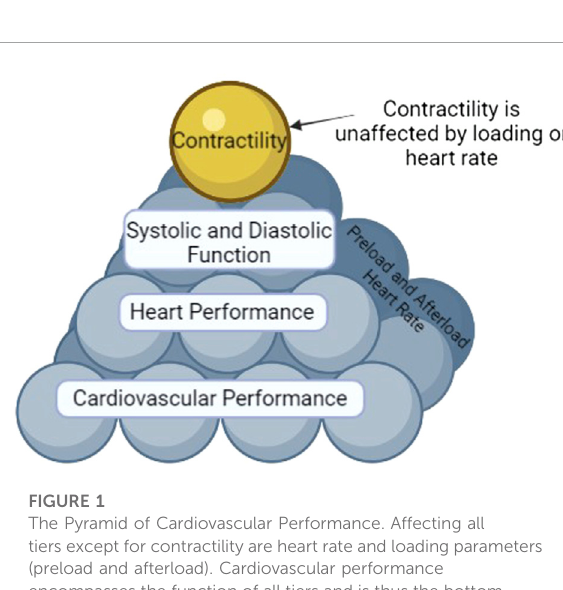
FIGURE 1 The Pyramid of Cardiovascular Performance. Affecting all tiers except for contractility are heart rate and loading parameters (preload and afterload). Cardiovascular performance encompasses the function of all tiers and is thus the bottom of the pyramid. Heart performance is a component of cardiovascular performance. Systolic and diastolic function and contractility are components of heart performance. However, AS contractility is by de fi nition an inherent, load and heart rate independent characteristic of the myocyte, it sits at the top of the pyramid, unaffected by heart rate or load like the other